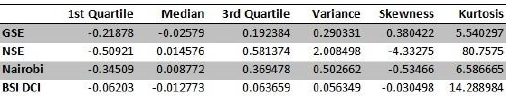
Table 1: Summary Statistics of the Returns of the Indices